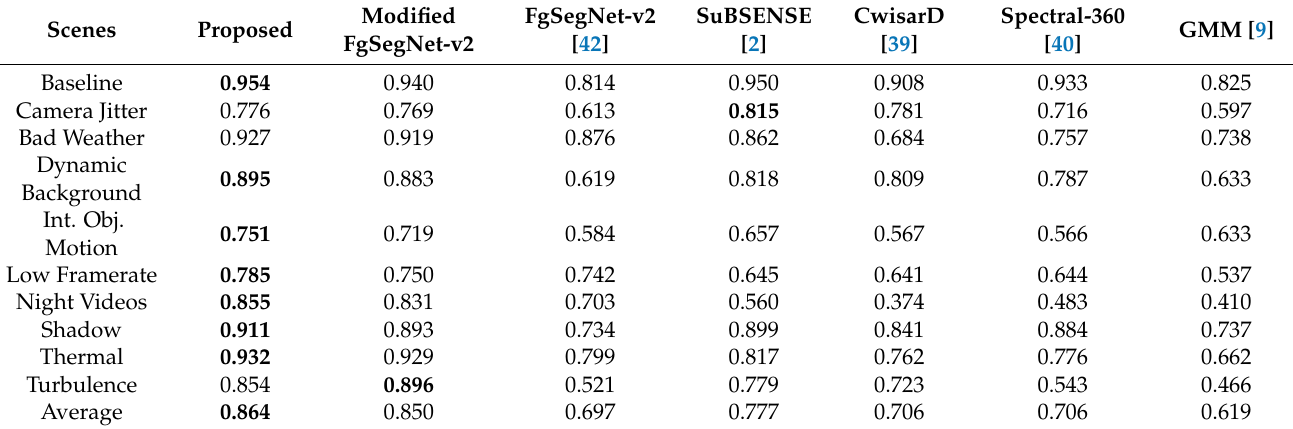
other algorithms. The proposed method, FgSegNet-v2 [42], and modified FgSegNet- v2 were trained using the same 24 scenes in the CDnet 2014 dataset. The proposed method, FgSegNet-v2, and modified FgSegNet-v2 are deep learning-based algorithms